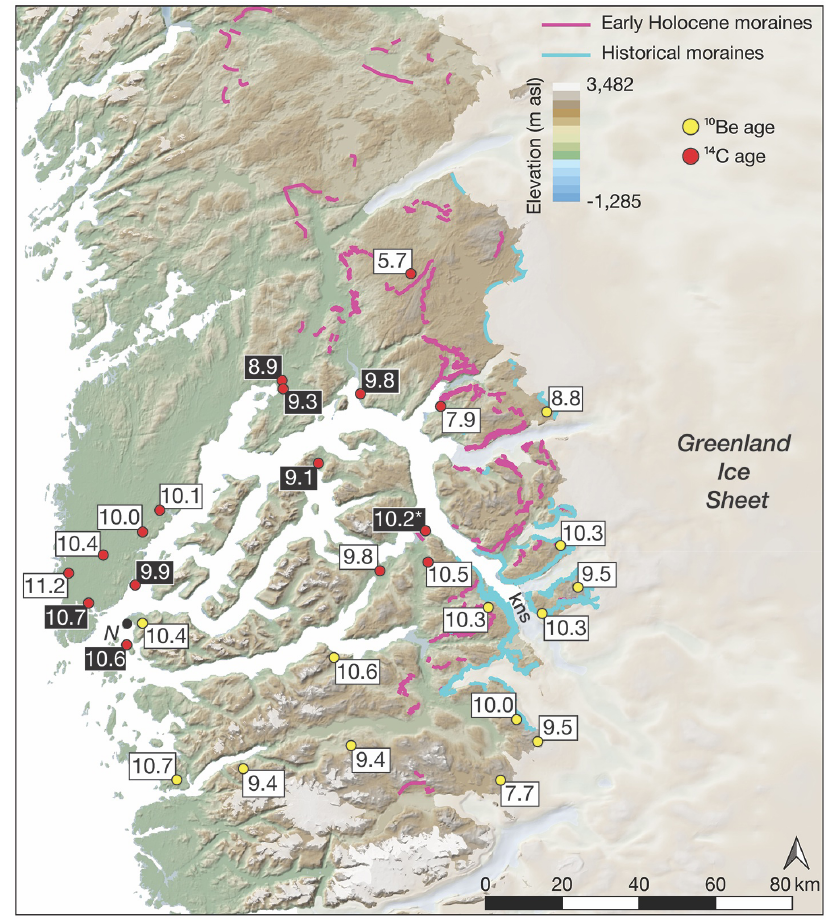
Figure 2. KNS region with geological constraints that track GrIS retreat in the Early Holocene. Radiocarbon ages (red circles) and 10 Be ages (yellow circles) are from Weidick et al. (2012), Larsen et al. (2014), and Young et al. (2021). For figure clarity, we only show the mean deglaciation age at each site (see Young et al., 2021, for full site descriptions). Radiocarbon and 10 Be across the immediate KNS region are similar and reveal that deglaciation of the coast occurred ca. 11.2–10.7ka, and KNS had retreated near or within its modern extent by ca. 10.3ka. Radiocarbon ages in white text and black background are from marine deposits and constrain the timing of retreat within the main fjord. The figure has been modified from Young et al. (2021).